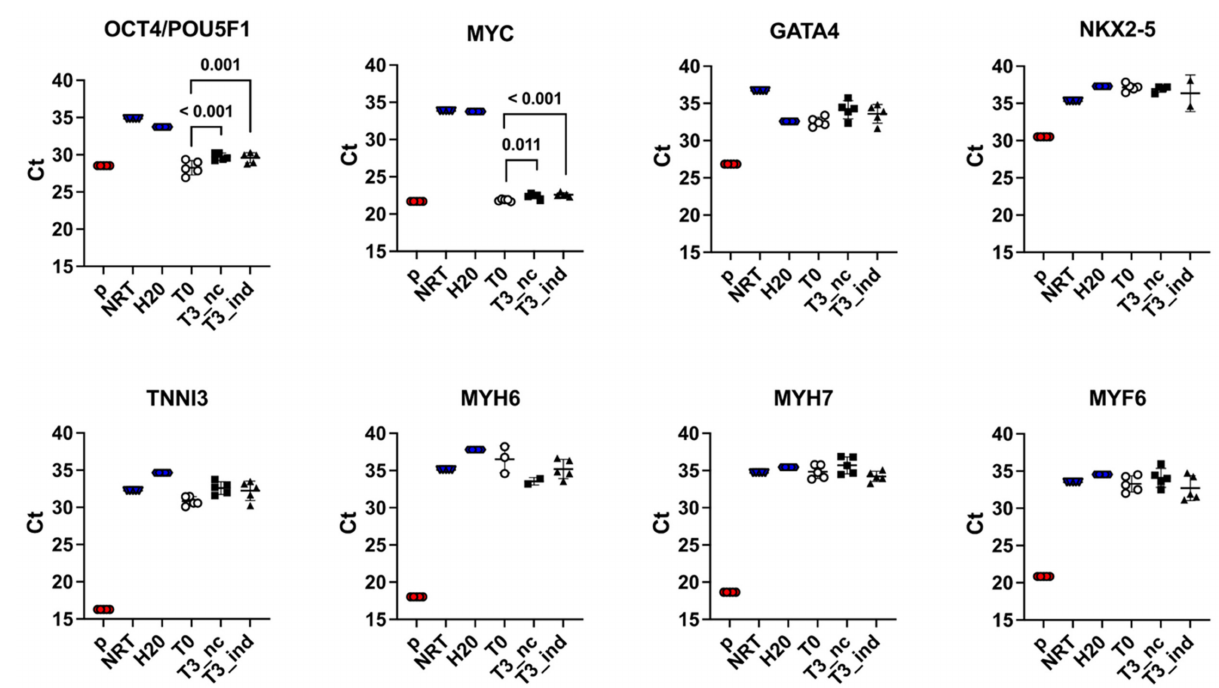
Figure 5. Results of the SYBR Green real-time quantitative PCR for the pluripotency, cardiac, and myogenic markers expressed in equine adipose-derived stem/stromal cells (ASCs) after exposure to 5-azacytidine (5-AZA) for 48 h. Gene expression at T0 (nonexposed) and T3 (exposed T3_ind, induced and T3_nc, negative control) as well as positive ( p , red color symbols) and negative control (nc as NRT and H 2 O controls, blue color symbols) are shown. Dot plots represent Ct mean values with standard deviation from two experimental runs ( n = 5 donors). One-way ANOVA (post hoc tests: Hochberg, Tukey’s HSD) was used for the statistical analysis. Statistical significance was set at p <